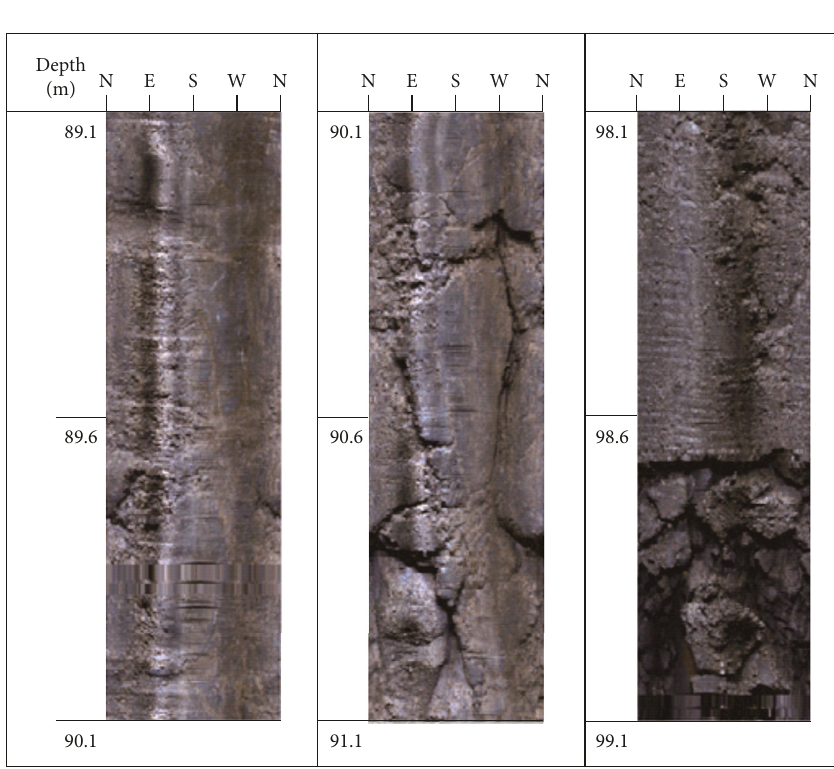
Figure 5: Parts of observed images of the K6 borehole. Table 3: Observation results of the H Borehole